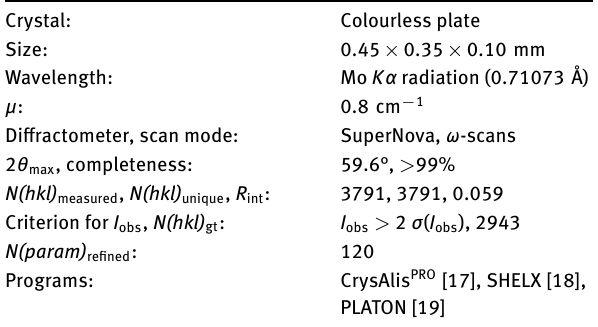
Table 2: Fractional atomic coordinates and isotropic or